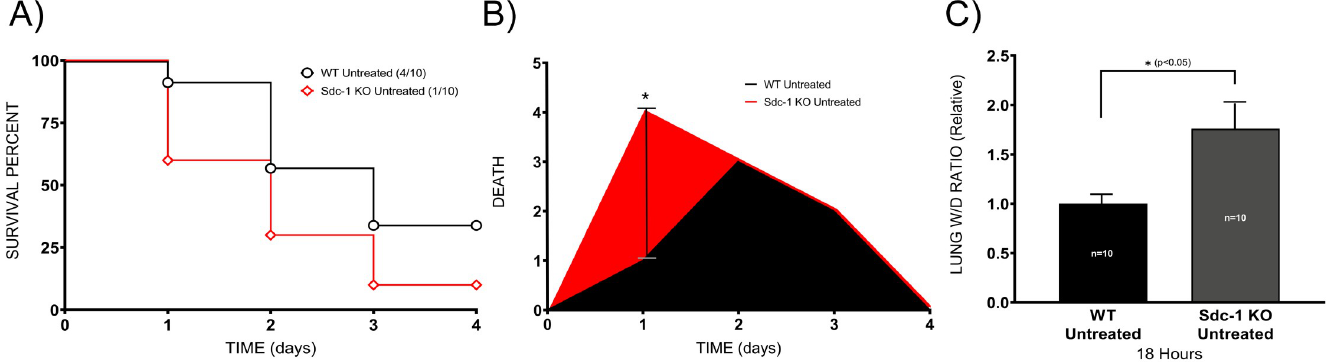
Fig 3. Sdc-1 KO mice are susceptible to sepsis. WT and Sdc-1 KO mice received a double hit injury of smoke and bacteria, and their survival was monitored for 96 hours (10 mice per group) (A). Death incidence was determined in relation to time, and results are shown in the area under the curve (B). Lung water content was determined at 18 hours by measuring the lung W/D weight ratio (10 mice per group) (C). Data are expressed as mean ± SEM ( � p <